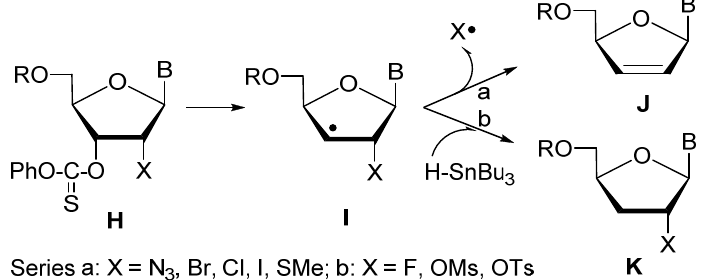
Figure 3. Bu 3 SnH / AIBN / ∆ treatment of 3 (cid:48) Figure 3. Bu 3 SnH/AIBN/ Δ treatment of 3´-thionocarbonates.